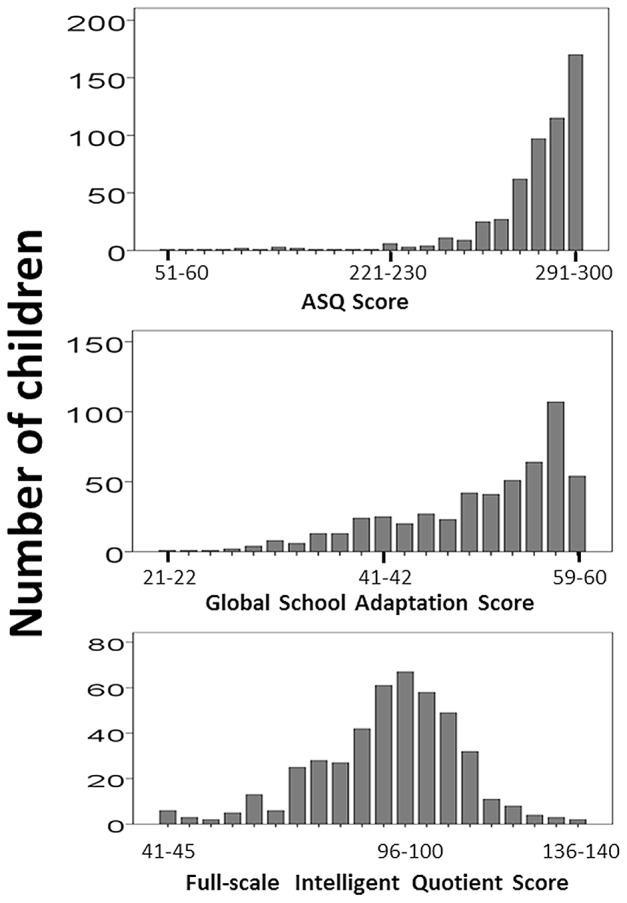
Distribution of global ASQ scores, GSA scores and full-scale IQ scores in study population.